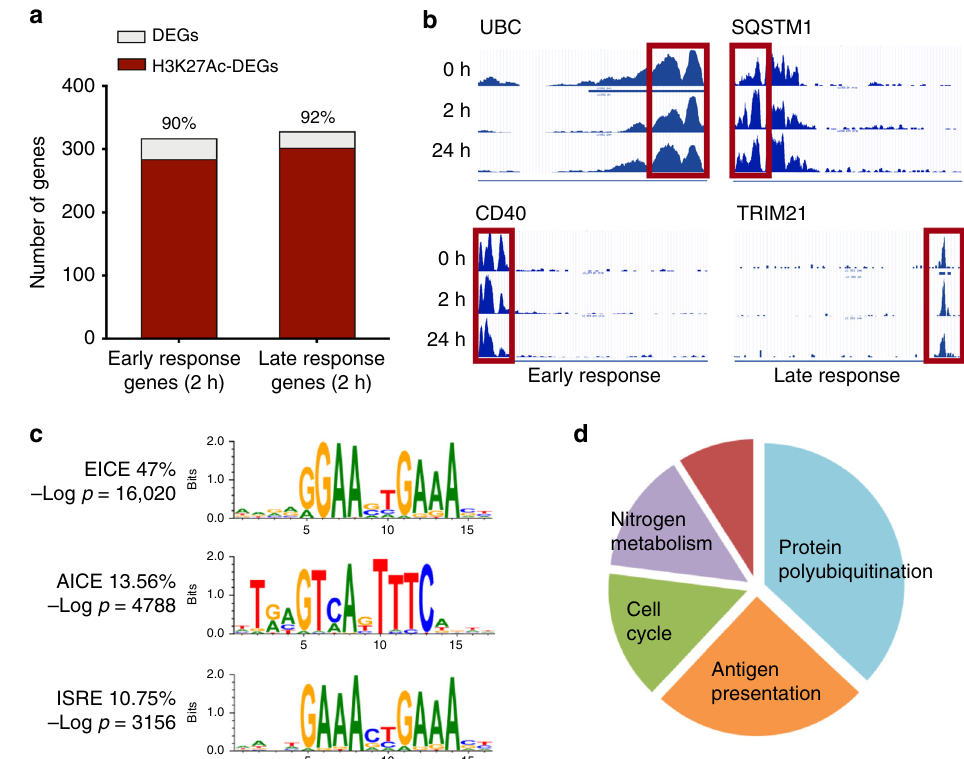
Fig. 4 Chromatin landscape of migrated LCs enriches for EICE, AICE and ISRE motifs. Human steady-state migrated LCs were subjected to whole- genome chromatin pro fi ling of H3K4me3 and H3K27Ac. a Proportion of DEG with H3K27Ac mark at 2 h in clusters of co-expressed genes upregulated early (2 h, clusters 3) and late (24 h, cluster 2) following stimulation with TNF. Changes in H3K27Ac acetylation were calculated using MANorm algorithm embedded in BioWardrobe tool. Genes were fi ltered to include unique common entry across the biological replicates (consensus value from n =